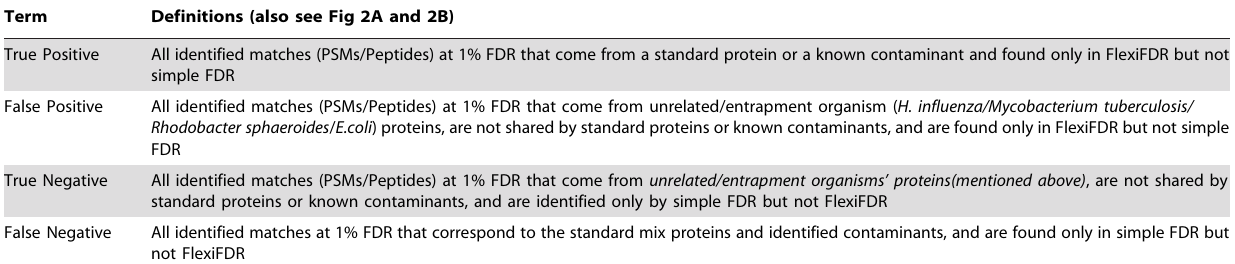
Term Definitions (also see Fig 2A and